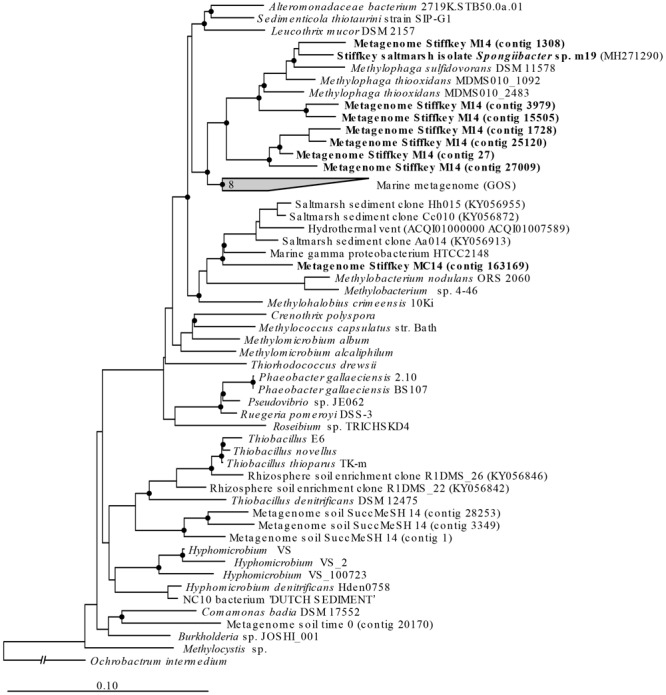
mtoX RAxML phylogenetic tree including the sequences retrieved from saltmarsh sediment assembled metagenomes. Environmental sequences obtained in this study are marked in bold. Time 0: sequences obtained from natural samples; M14: sequences retrieved from MeSH enrichments after 14 days of incubation; C14: sequences yielded by 14-day enriched samples with mixed carbon source; MC14: sequences obtained from enrichments with MeSH plus C after 14 days of incubation. Bar, 0.10 substitutions per amino acid position. Bootstrap values ≥ 75% (based on 100 replicates) are represented with dots at branch points.